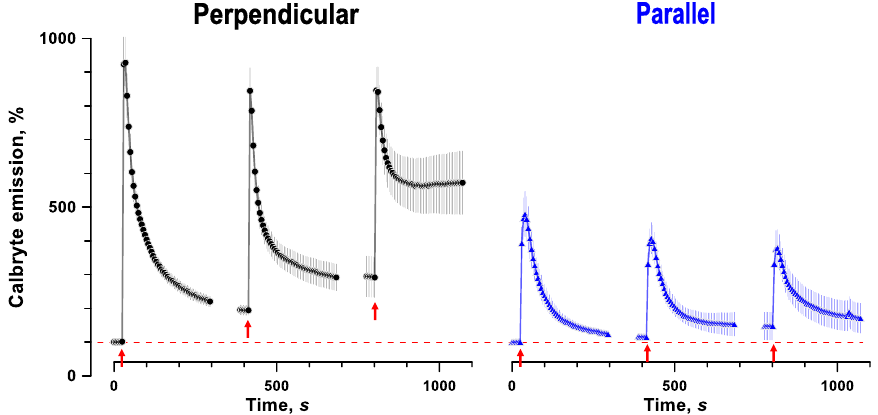
Figure 5. Calcium transients evoked by 300-ns, 14 kV/cm pulses in smooth muscle cells oriented perpendicular or parallel to the electric field (left and right panels, respectively). Each cell was stimulated three times (arrows). Note stronger response and impaired recovery to the baseline in cells oriented perpendicular to the field. Mean ± SEM, n =